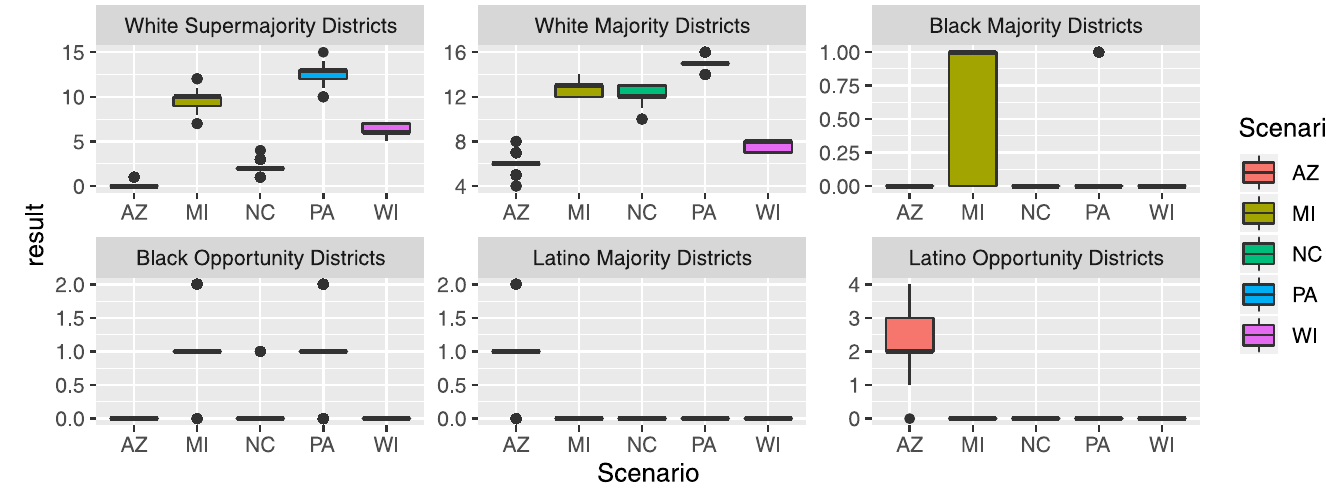
Fig 3. Minority majority metrics for the created plans.